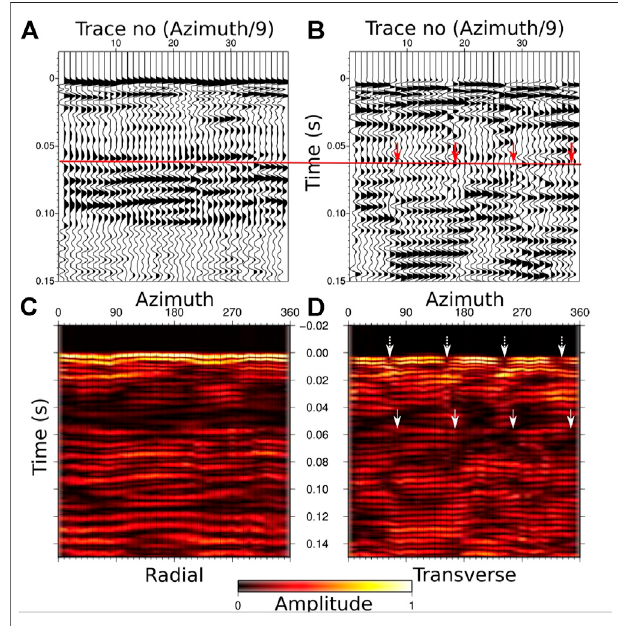
FIGURE 7 | 9 ° azimuth stacks recorded on OBS8 located on the southwestern rim of the Scanner Pockmark. Left and right panels show radial and transverse components respectively. (A) Radial wiggle plot. The red line shows the arrival time ( ∼ 55 ms TWT) of the C-wave phase on the radial seismogram. (B) Transverse wiggle plot. Red arrows show the polarity reversals. (C) Radial envelope plot of the amplitudes (root of squared amplitudes). (D) Transverse envelope plot. White arrows show the amplitude nullsof ∼ 90 ° degreeinterval,correspondingtotheorientationoftheanisotropy axes (70 and 150 ° ). Dashed white arrows at t (cid:2) 0 indicate the geophone